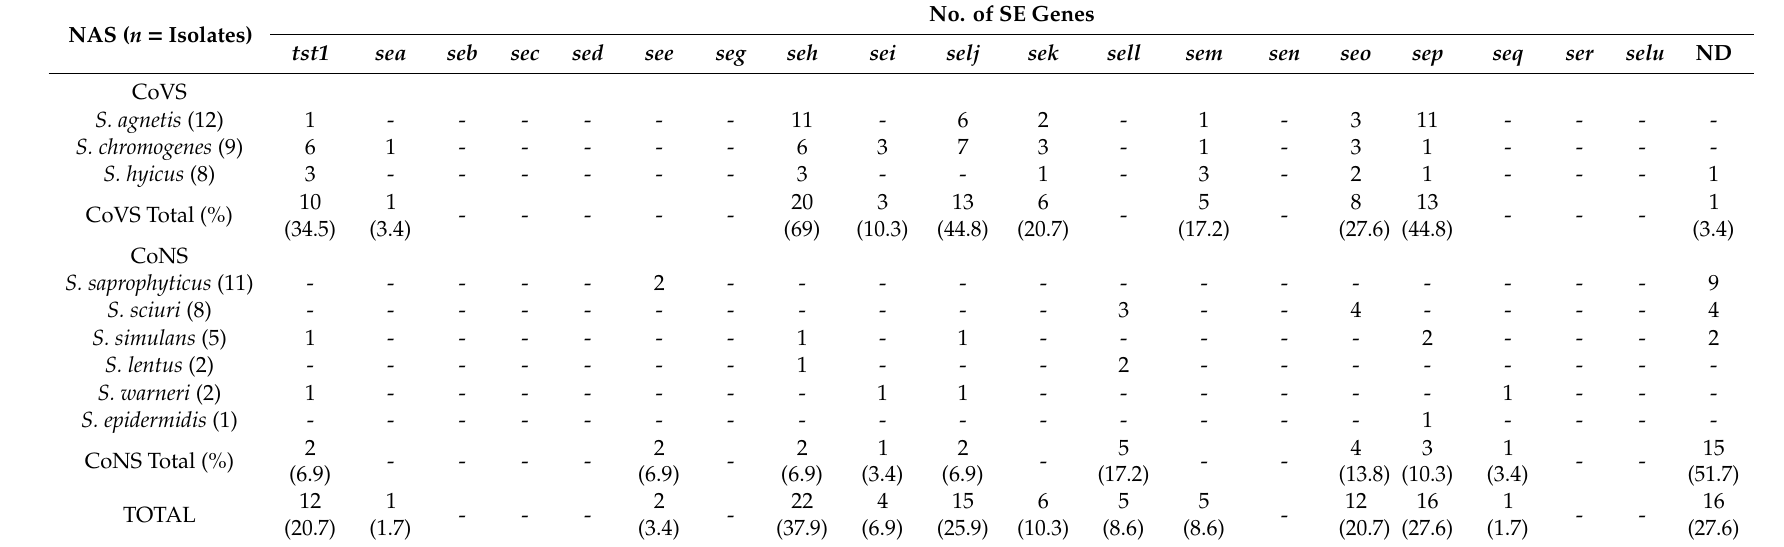
Table 5. Prevalence of TSST-1, classical SE, and newer SE genes in non- aureus staphylococci (NAS) strains isolated from retail chicken meat. NAS ( n =